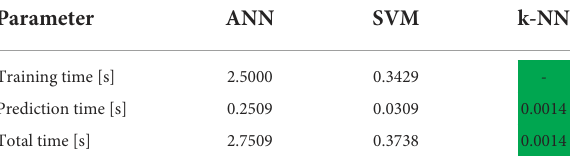
TABLE 6 Time comparison of predictive methods.